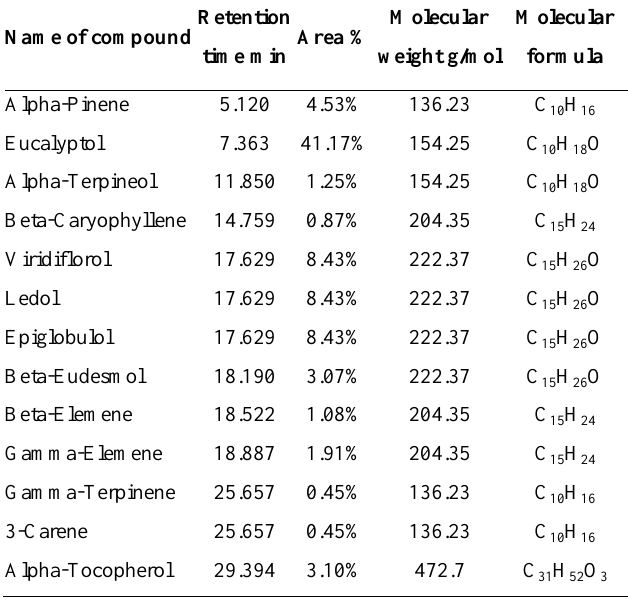
Table 1: Components of essential oil analyzed by GC-MS